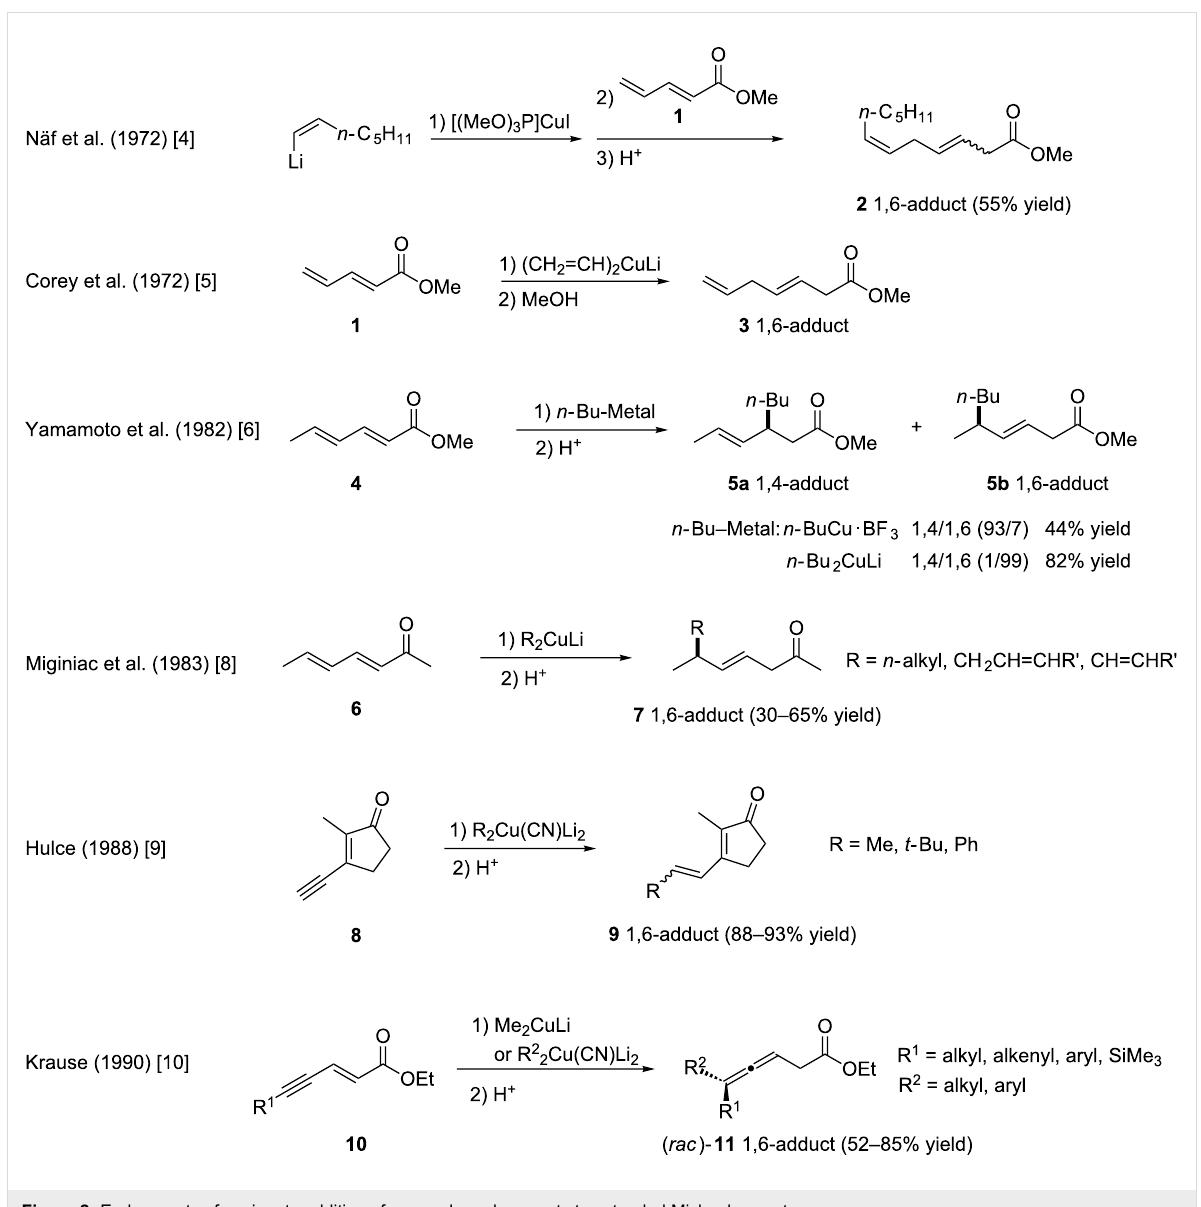
prompted research groups to investigate thoroughly the mecha- nism of this reaction